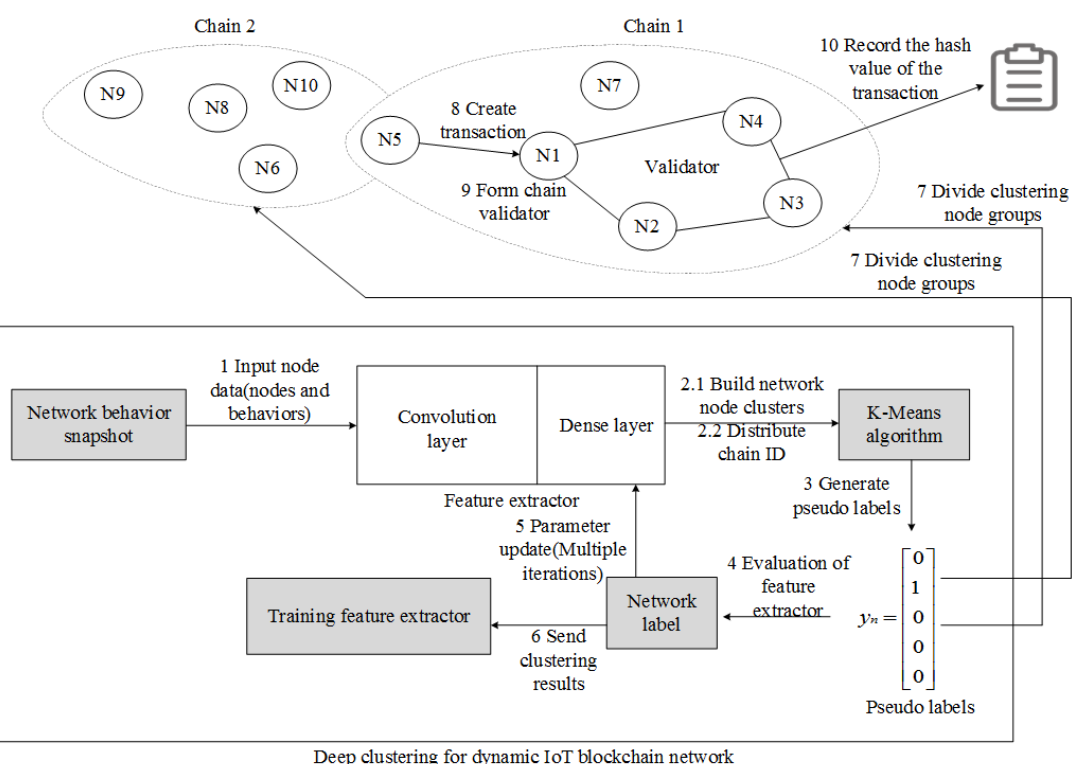
Figure 6. Reconstruction diagram of reference [27].